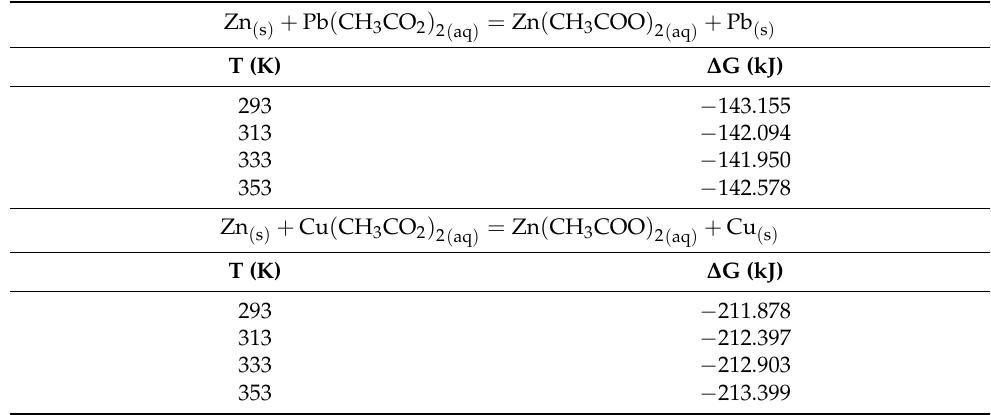
Table 2. Thermodynamic conditions for cementing lead and copper using powder